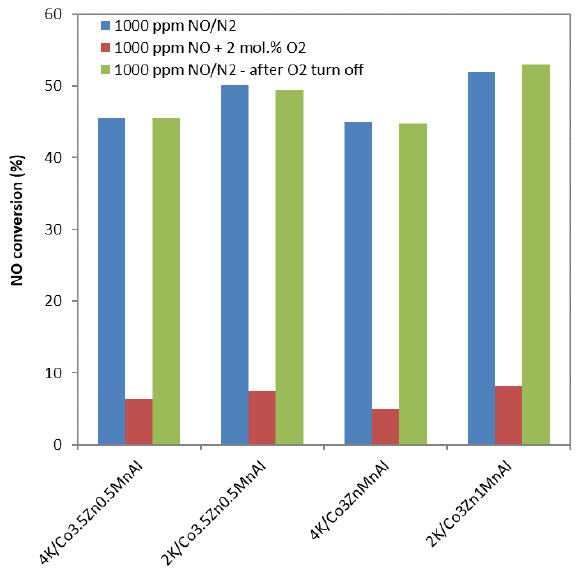
Figure 10. NO conversion over potassium-promoted Co-Zn-Mn-Al mixed oxide catalysts at 700 °C.